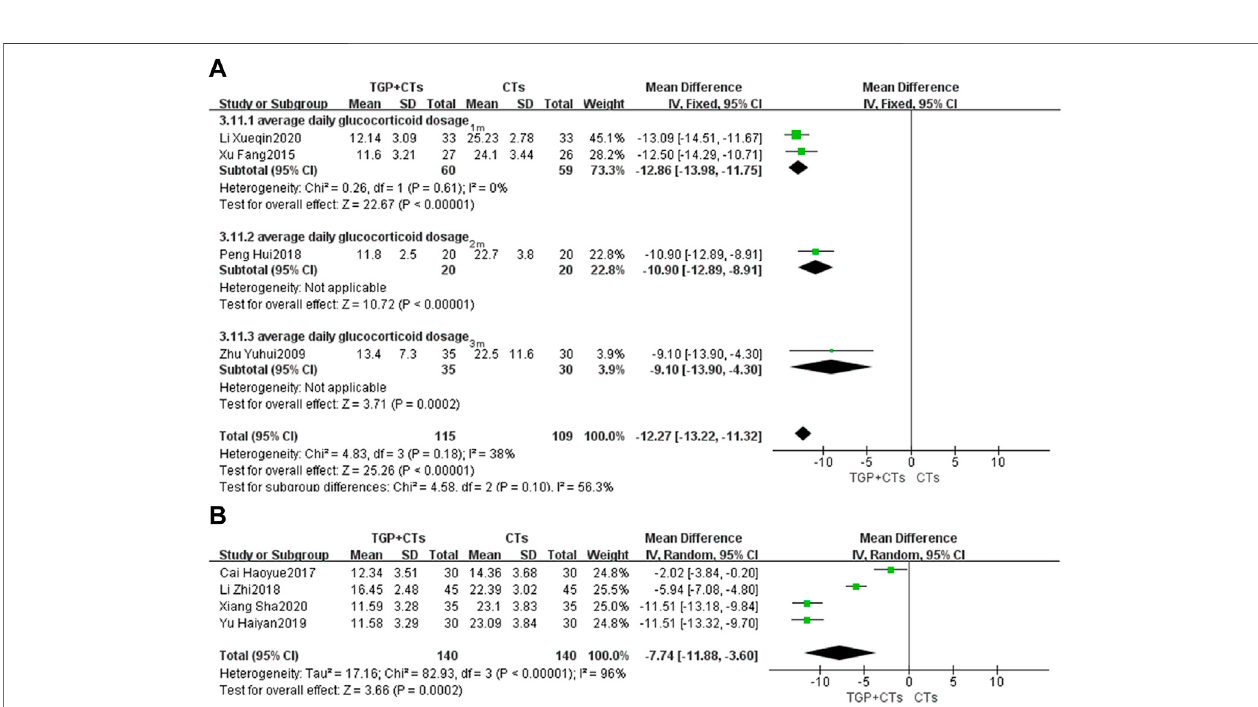
FIGURE 8 | Forest plot of average daily glucocorticoid dosage at 1 month, 2 and 3 months (A) and 6 months (B) .